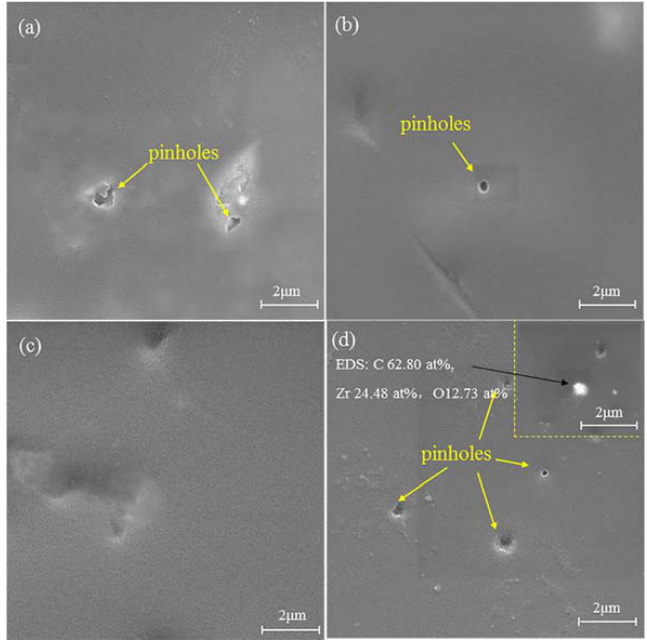
Figure 2. SEM images of different nano-ZrO 2 -modified coatings before acid immersion: Z-0 coating ( a ), Z-1 coating ( b ), Z-3 coating ( c ), and Z-5 coating ( d ).